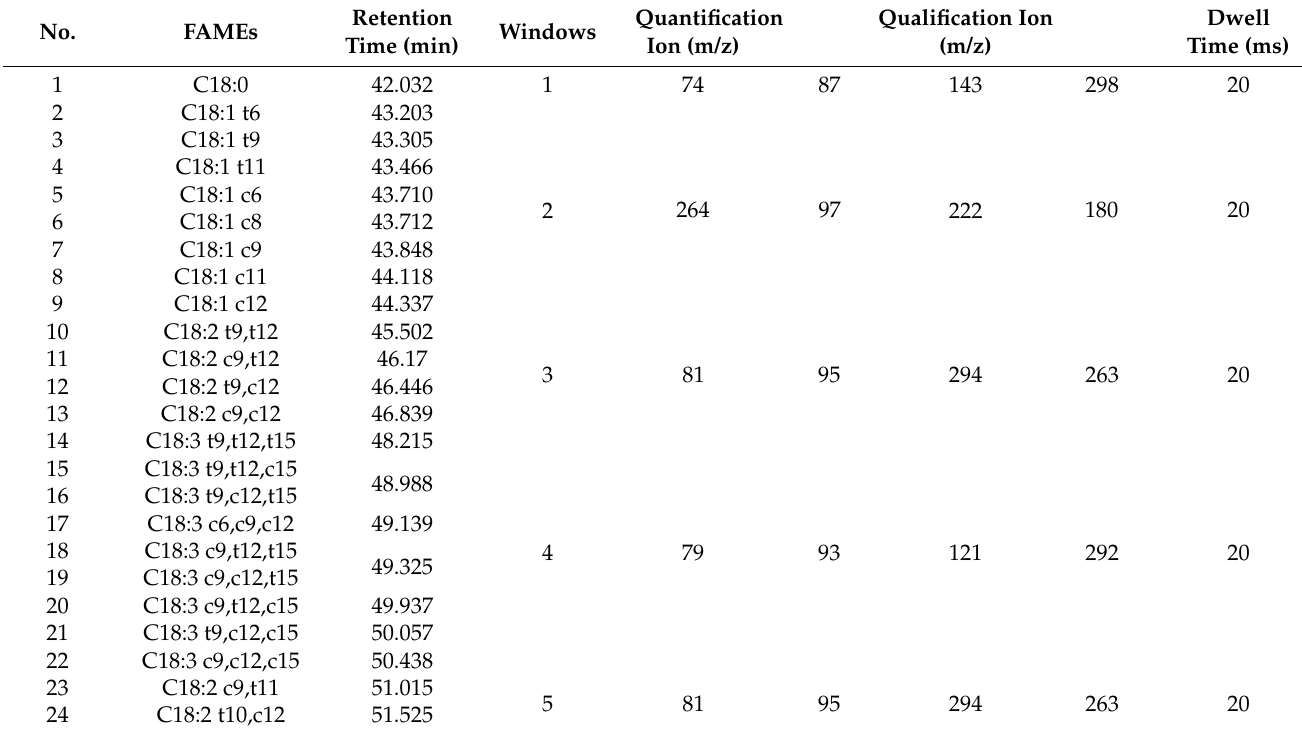
Table 1. GC-MS parameters for determination of C18